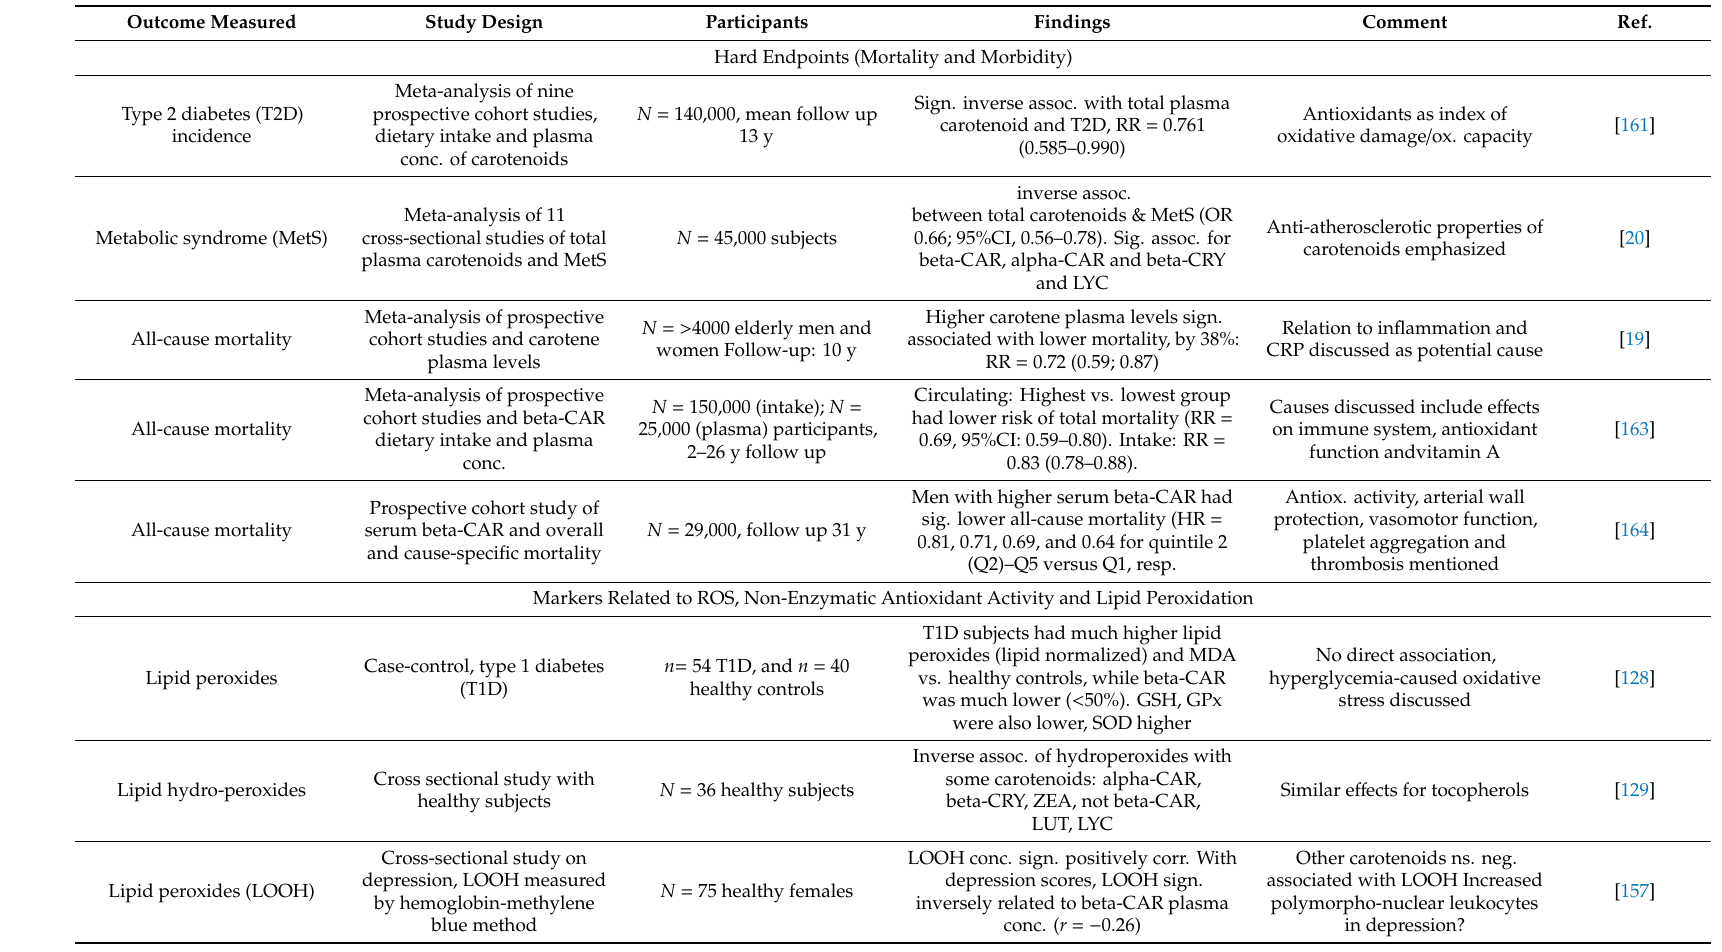
Table 3. Markers of oxidative stress in human observational